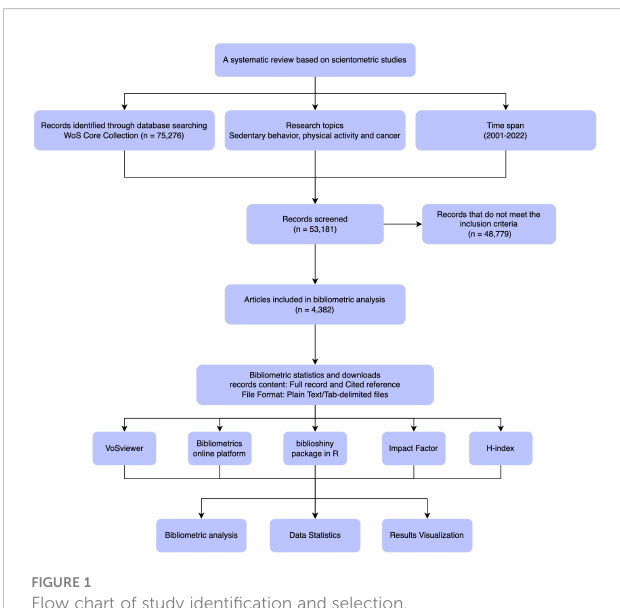
FIGURE 1 Flow chart of study identi fi cation and